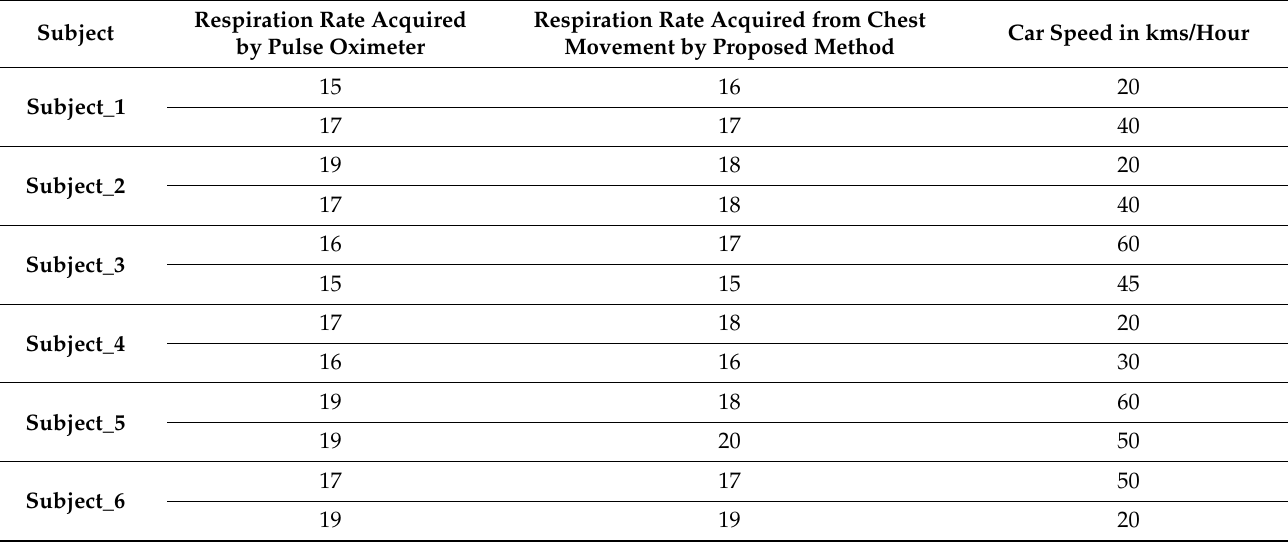
Figure 11. Subject driving car. Table 2. Results of experiment conducted in real environment.